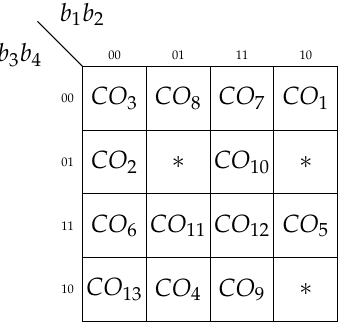
Figure 7. Codes of the COs for FSM